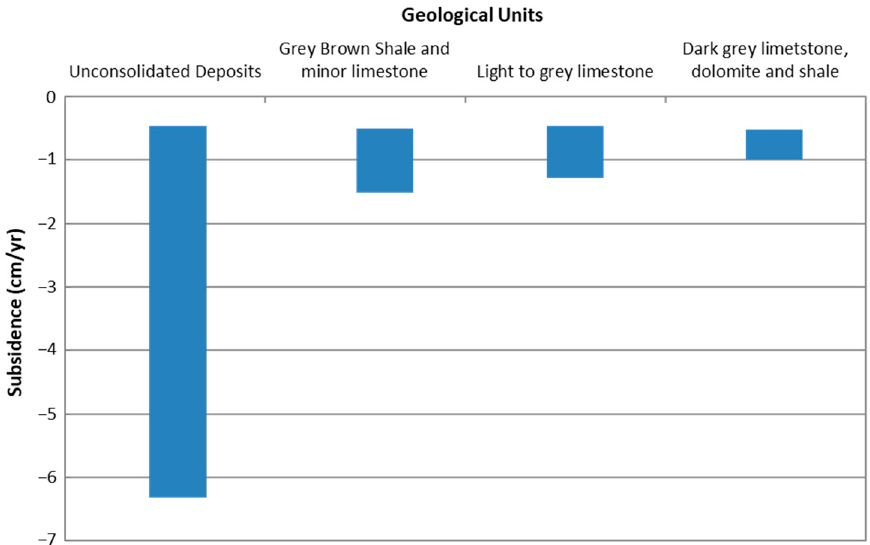
Figure 10. Relationship between geological units and average subsidence rate.